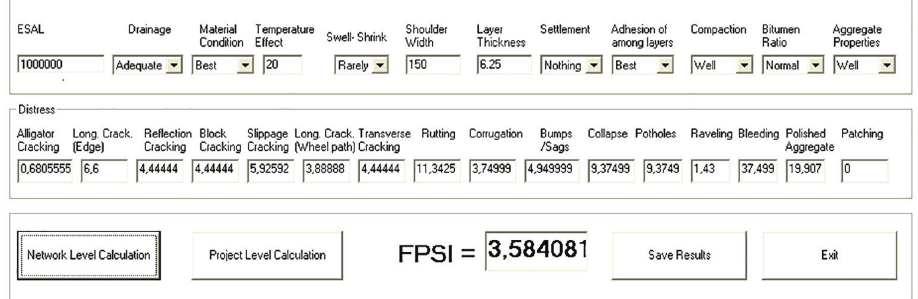
Fig. 8. Result of the calculation of FPSI value